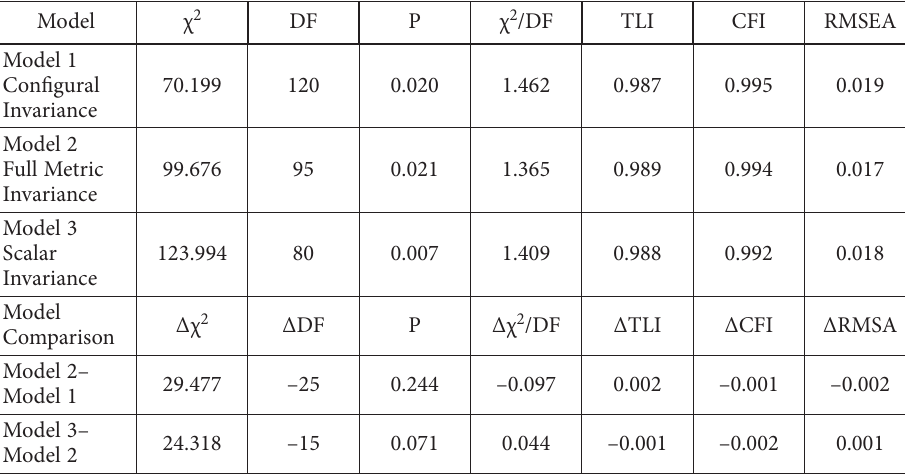
Table 7. Cross-cultural measurement invariance tests